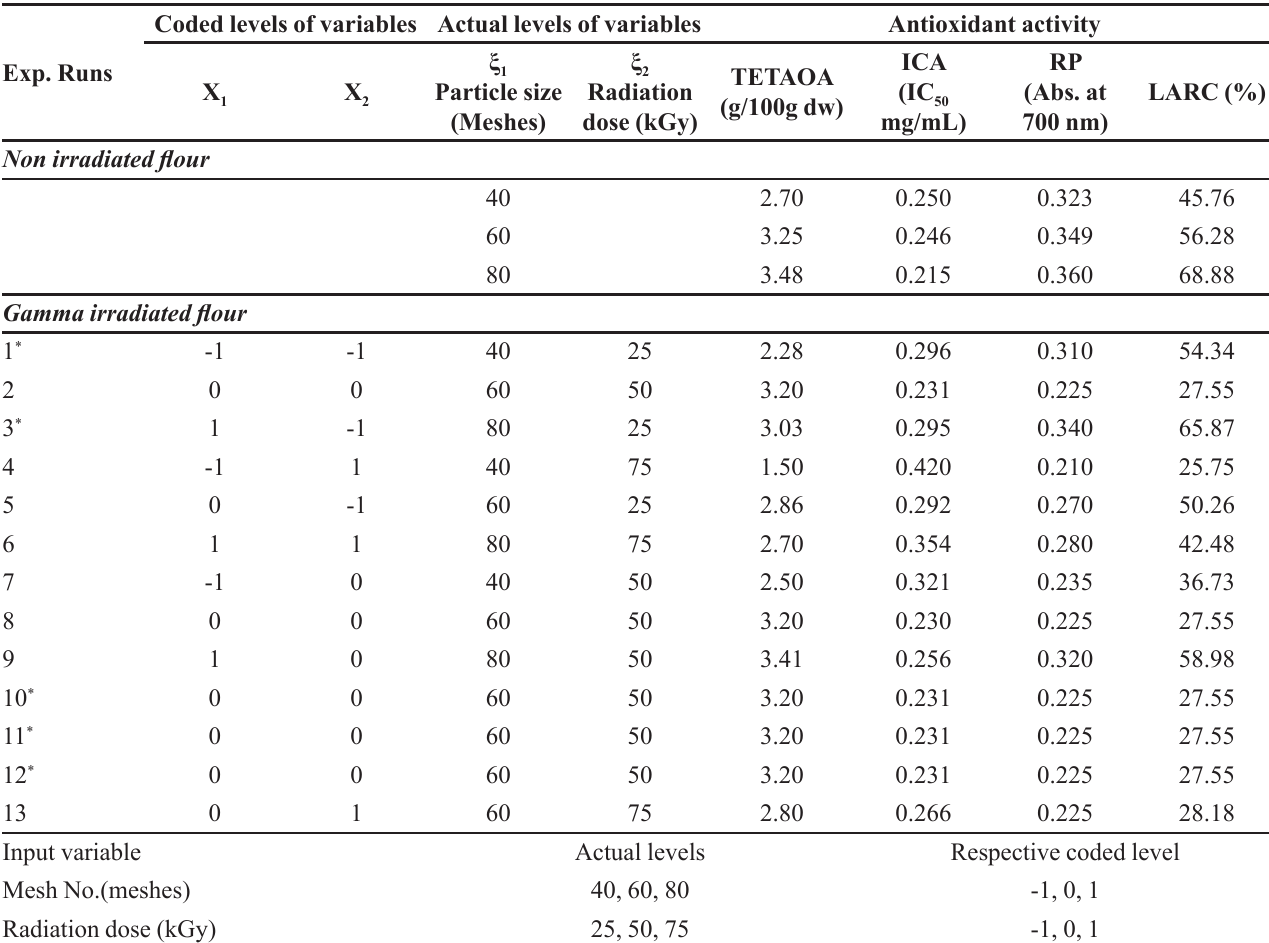
TABLE I - The experimental values of antioxidant activity of maize flour at random levels of experimental conditions as per chosen by central composite design